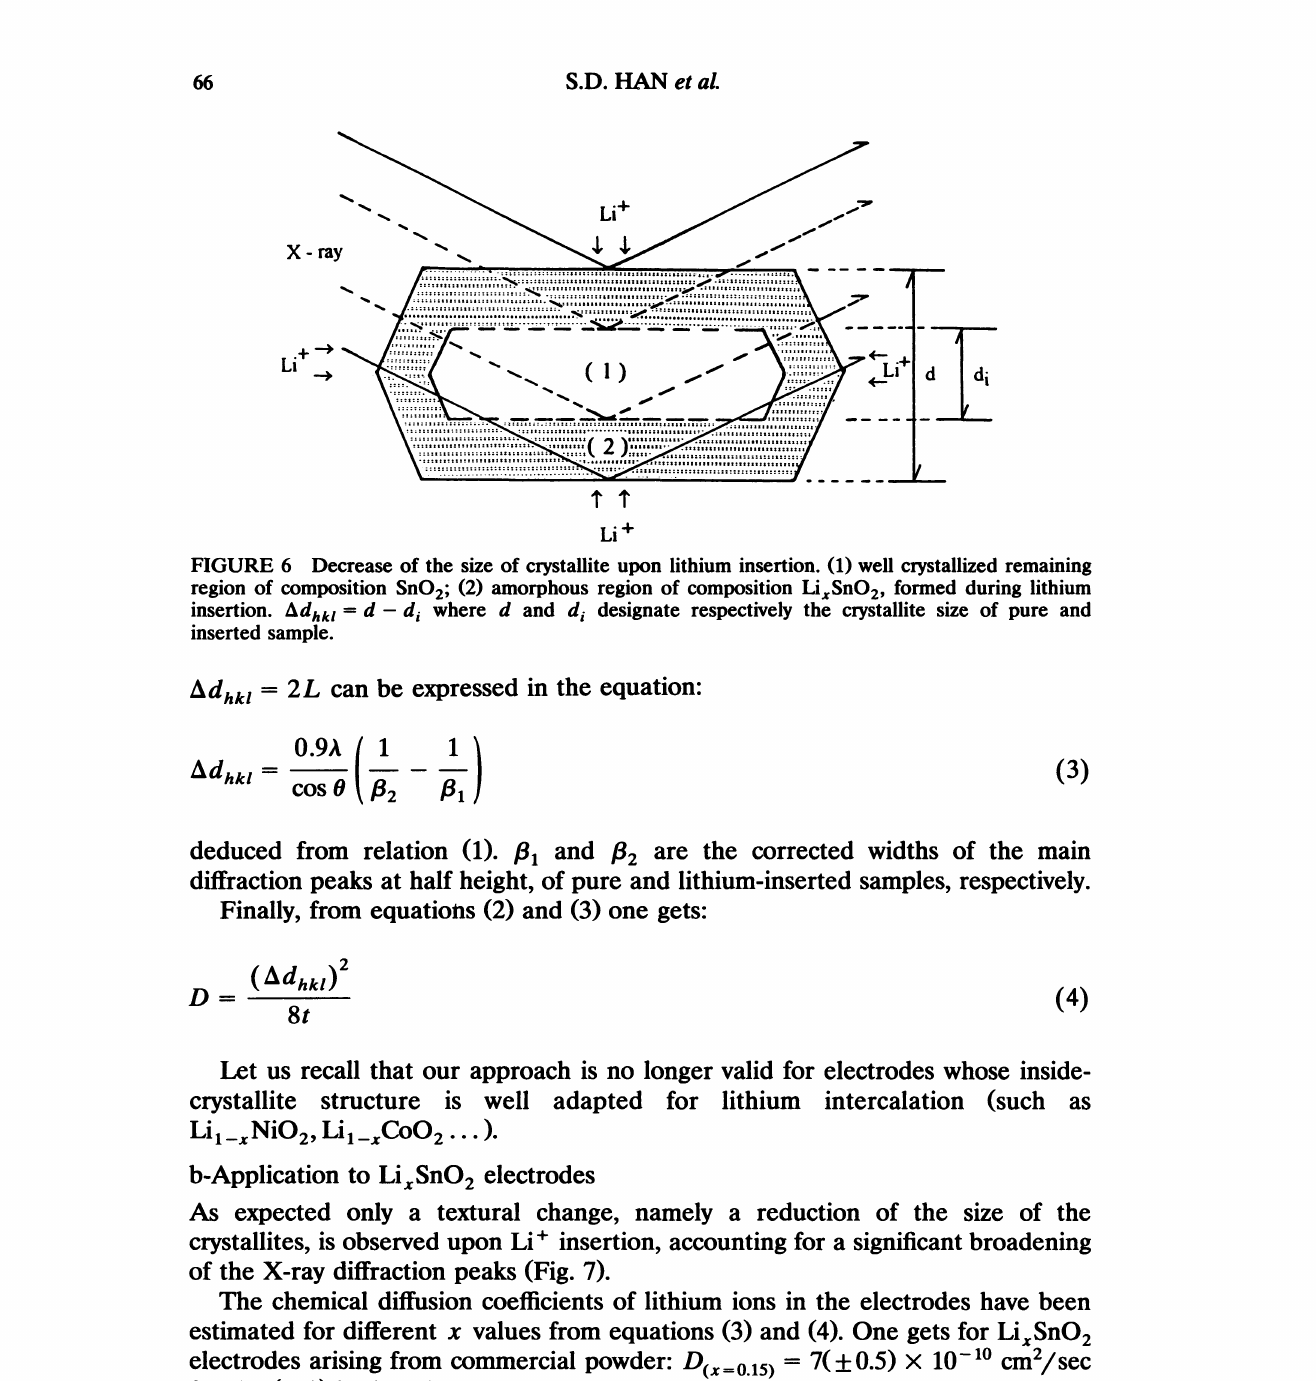
1 deduced from relation (1). /31 and f12 are the corrected widths of the main diffraction peaks at half height, of pure and lithium-inserted samples,